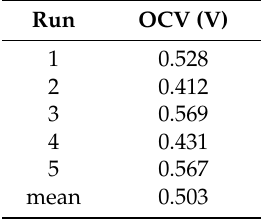
Figure 5. Results of constant current of the RED stack equipped with normal CEMs (CMX) and pseudo AEMs (Ag/AgCl). Table 7. OCV (Open Circuit Voltage) of the stack before each MPPT run.